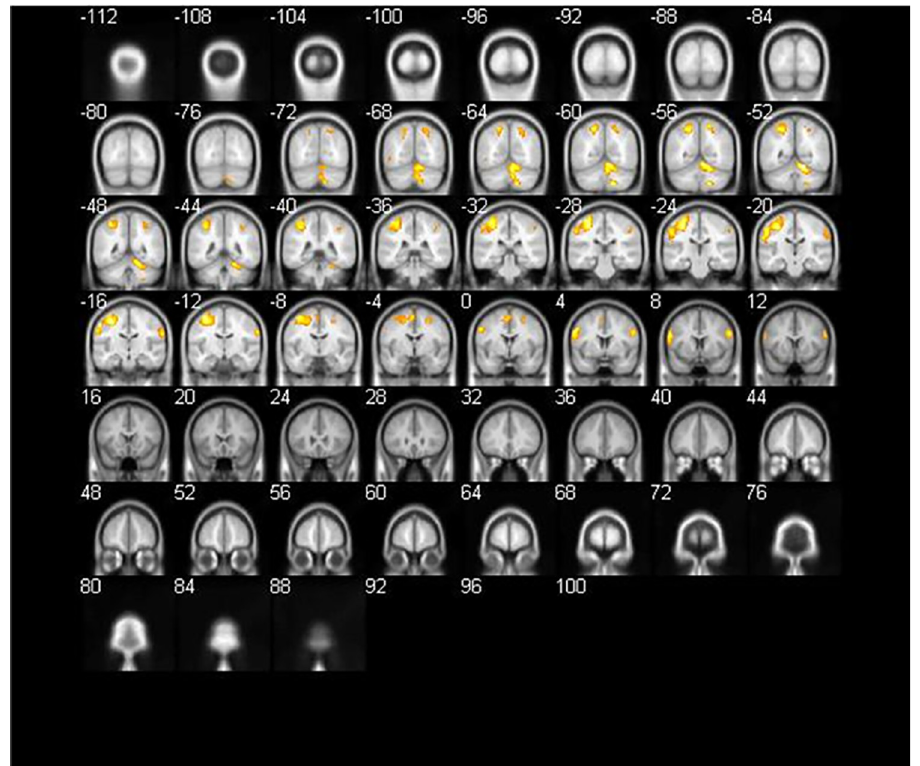
Fig 5. Brain activation for copy drawing (A2) versus viewing (A1) (coronal section).